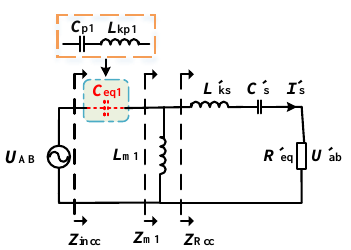
Figure 5. Equivalent circuit of Figure 4 with reference to the primary side.